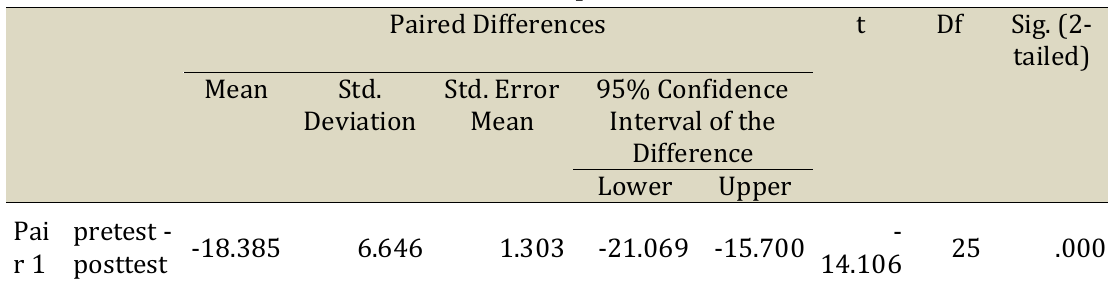
Table 4.5 The Paired Sample Test of pretest and